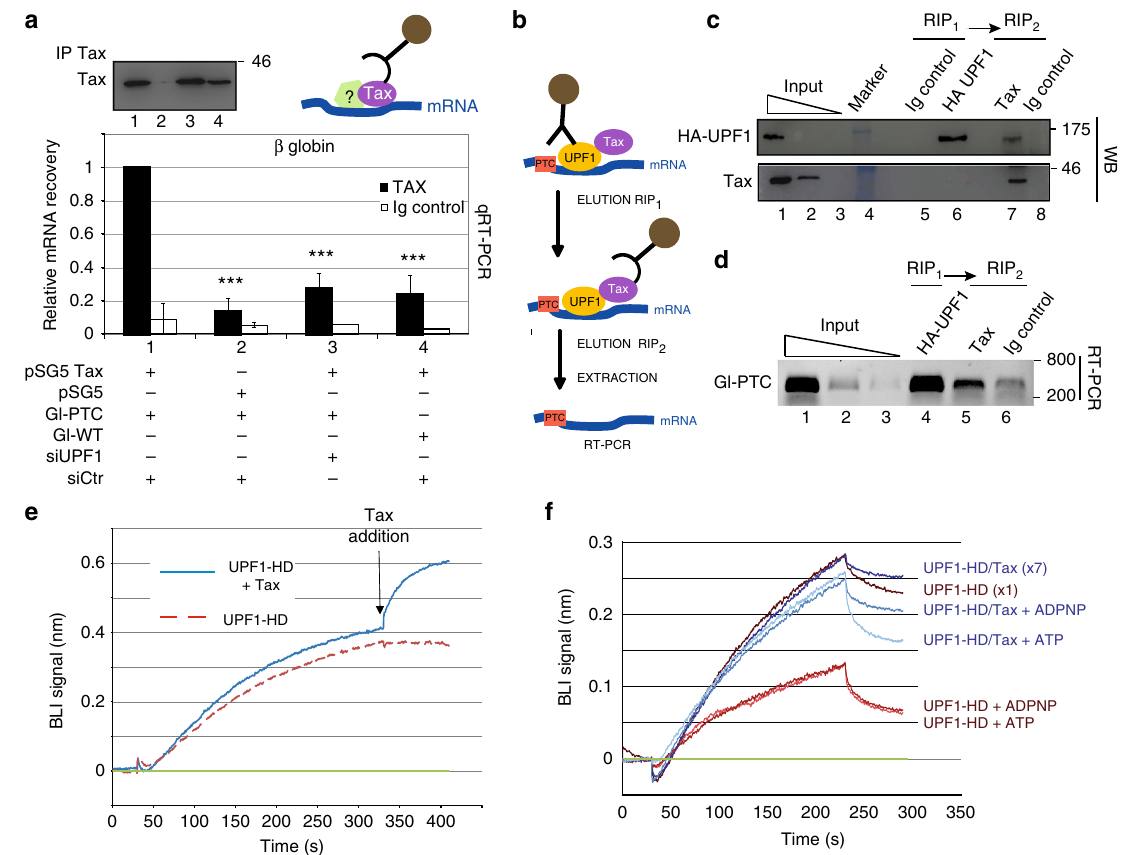
Fig. 4 The UPF1-HD/Tax complex shows residual RNA-binding ability. a Quanti fi cation of precipitated Gl-PTC from Tax immunoprecipitation (black bars) vs. IgG immunoprecipitation control (white bars) using the globin 3 ′ oligos. The histogram represents the quanti fi cation of relative RNA recovery upon normalisation to input RNA under condition 1 that was set to 1. The ΔΔ Ct method of mRNA quanti fi cation was applied to each experimental condition. The construct encoding Tax (conditions 1, 3 and 4) or empty vector (lane 2) were co-transfected with reporter plasmids expressing Gl-PTC (lanes 1 – 3) or Gl- WT (lane 4). The cells were treated with non-targeting siRNA (siCtr; lanes 1, 2 and 4) or UPF1 siRNA (siUPF1; lane 3). The values represented in each graph correspond to the mean of at least three biological replicates, and the error bars correspond to the SD. *** P < 0.005 with Student ’ s t- test (two-tailed, unpaired). Immunoprecipitated Tax was analysed by western blotting using anti-Tax antibody (upper left panel). b Schematic representation of the double- RIP work fl ow. c Western blot analysis monitoring the presence of both UPF1 and Tax in each fraction. d Agarose gel showing the products of RT-PCR using globin 3 ′ oligonucleotides with input and immunoprecipitated RNA samples. e Real-time sensorgram of the Bio-Layer interferometry experiment showing UPF1-HD binding to 5 ′ -biotinylated 30mer-DNA (red dashed line), and the interaction of UPF1-HD with Tax CACA when Tax CACA was added at 330 s (blue line). f Association and dissociation curves of UPF1-HD (10 nM) and UPF1-HD/Tax (70 nM) preformed complex to the DNA-coated sensor with or without ATP or ADPNP. Given that the k on of the UPF1-HD/Tax CACA complex is one order of magnitude lower than that UPF1-HD, the concentration of the protein complex was adjusted to have almost the same association kinetics with DNA than the enzyme alone. Biosensor DNA tips were loaded with: UPF1-HD (brown), UPF1-HD supplemented with 2 mM of ADPNP (red) or 2 mM of ATP (orange), UPF1-HD/Tax (dark blue), UPF1-HD/Tax supplemented with 2 mM of ADPNP (middle blue) or 2 mM of ATP (light blue). Uncropped scans related to Fig. 4 are available in Supplementary Fig.